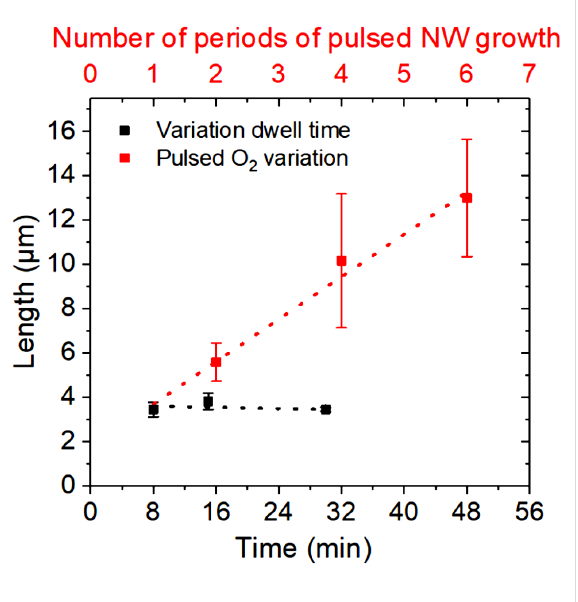
Figure 9: Comparison of the laterally aligned NW lengths: for different process times (black, compare to Figure 6) and for a pulsed gas inflow for a different number of repeating steps (periods) (red, compare to Figure 8) catalyzed by Au NPs (Ø 80